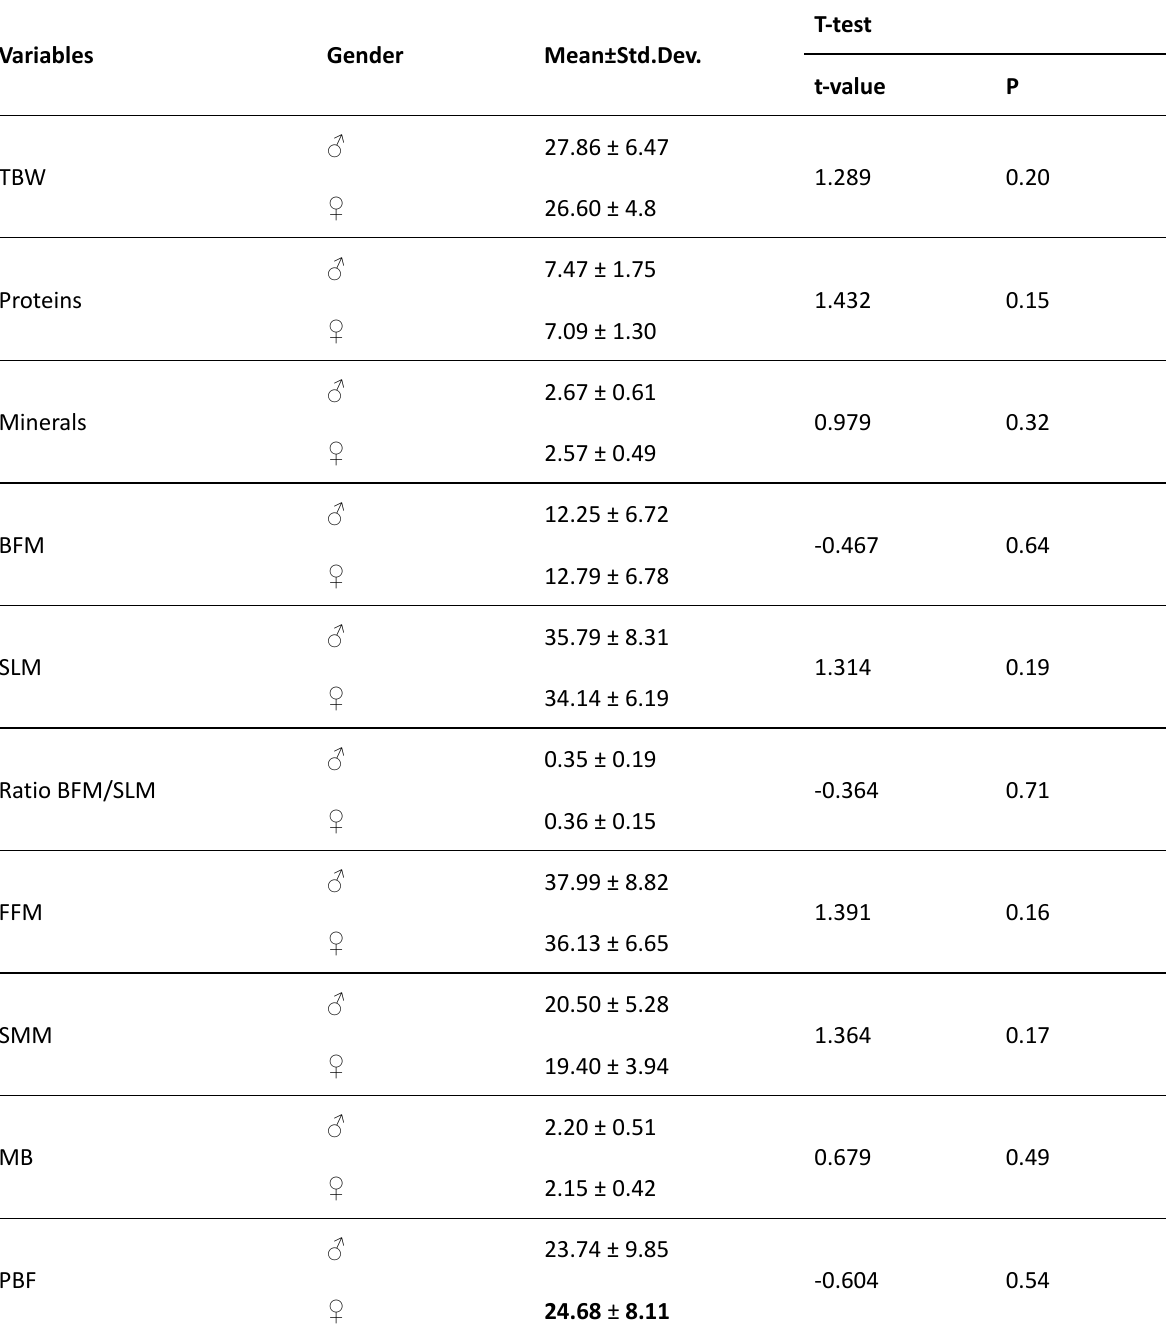
Table 4. Differences in the body composition between boys and girls – Descriptive statistic, T-test Variables Gender Mean±Std.Dev.